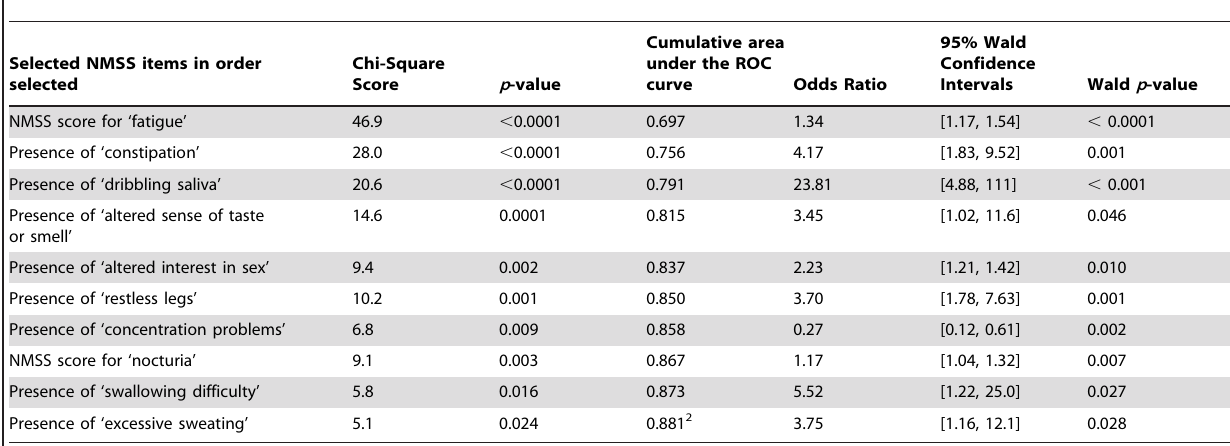
Table 5. Selection of NMSS items by stepwise logistic regression 1 to discriminate between PD patients (n =200) and healthy controls